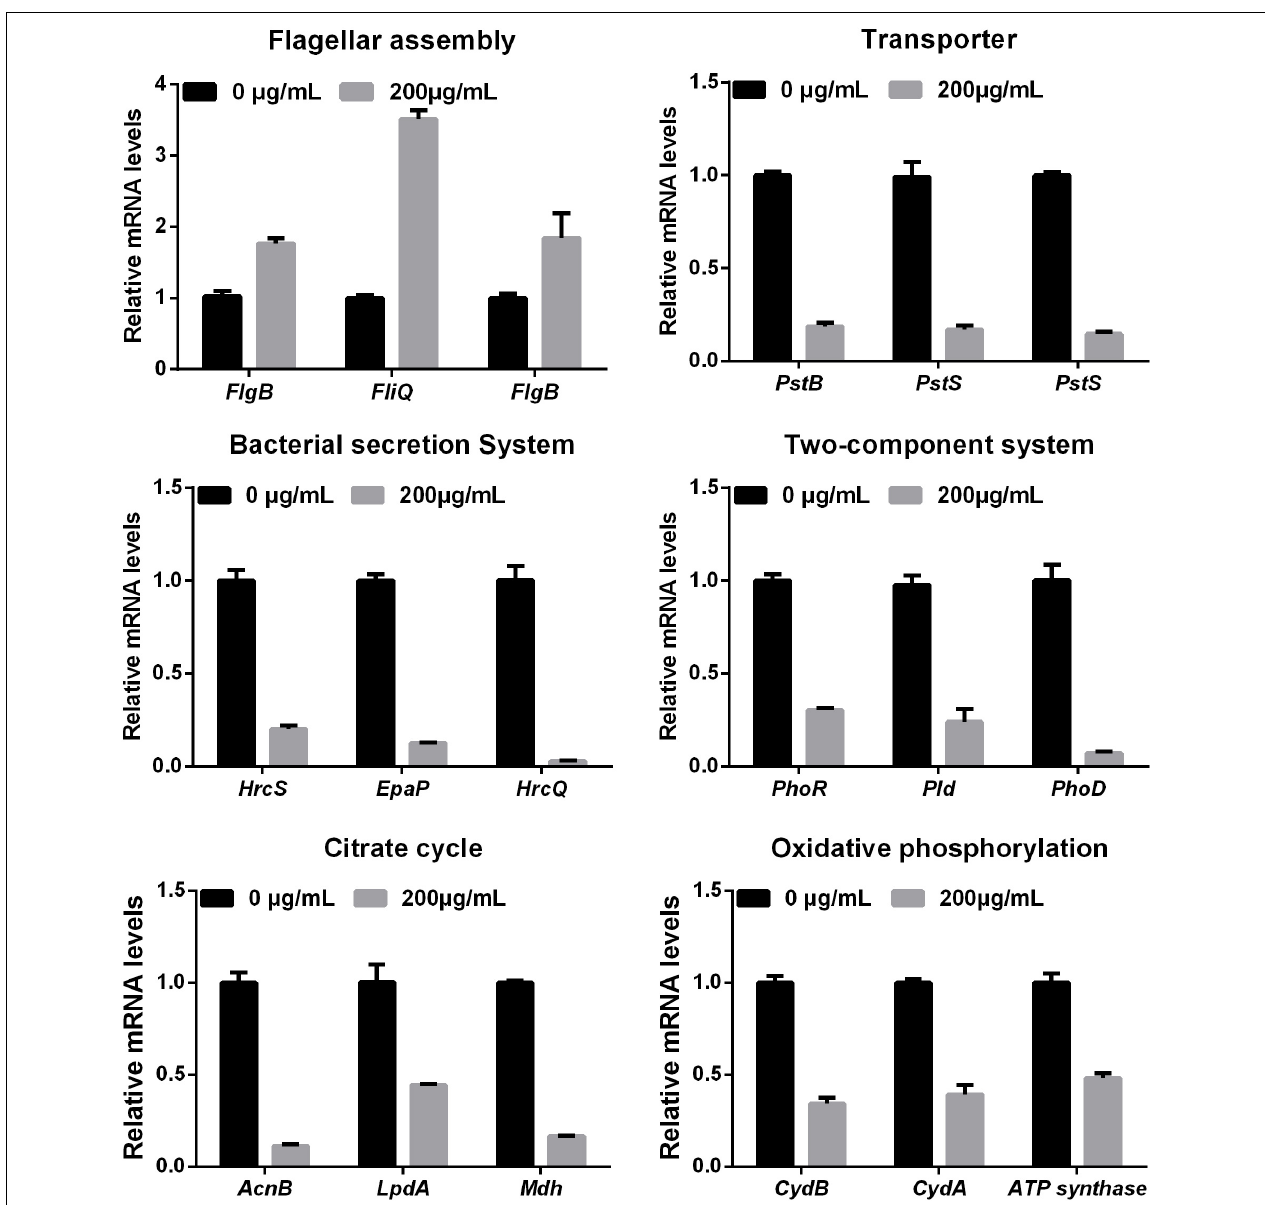
FIGURE 7 | Validation of 18 differentially expressed genes at the mRNA level by